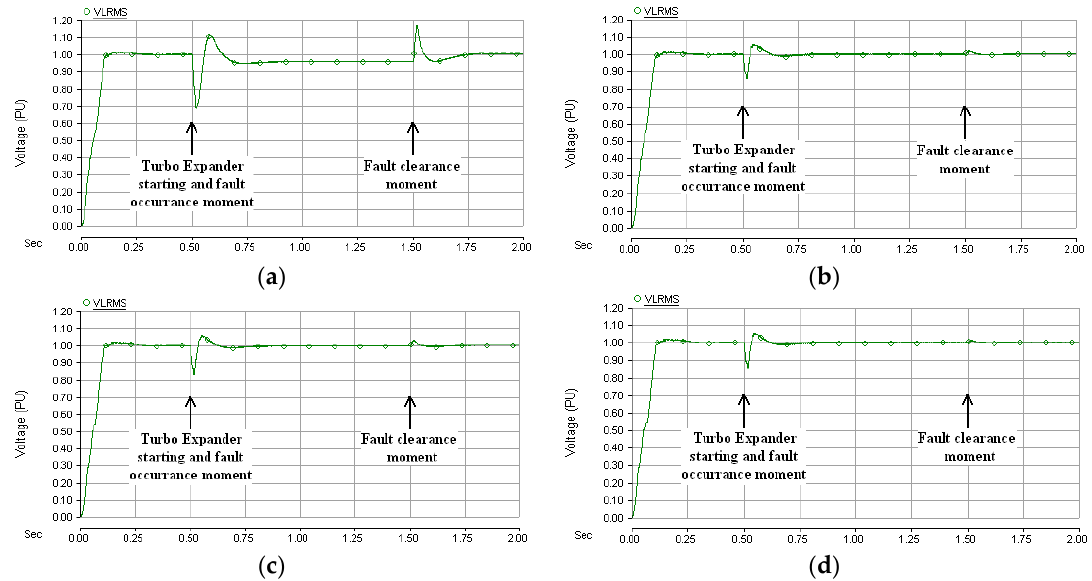
Figure 8. SATCOM performance at bus 3: ( a ) Scenario 9; ( b ) Scenario 10; ( c ) Scenario 11; and ( d ) Scenario 12.